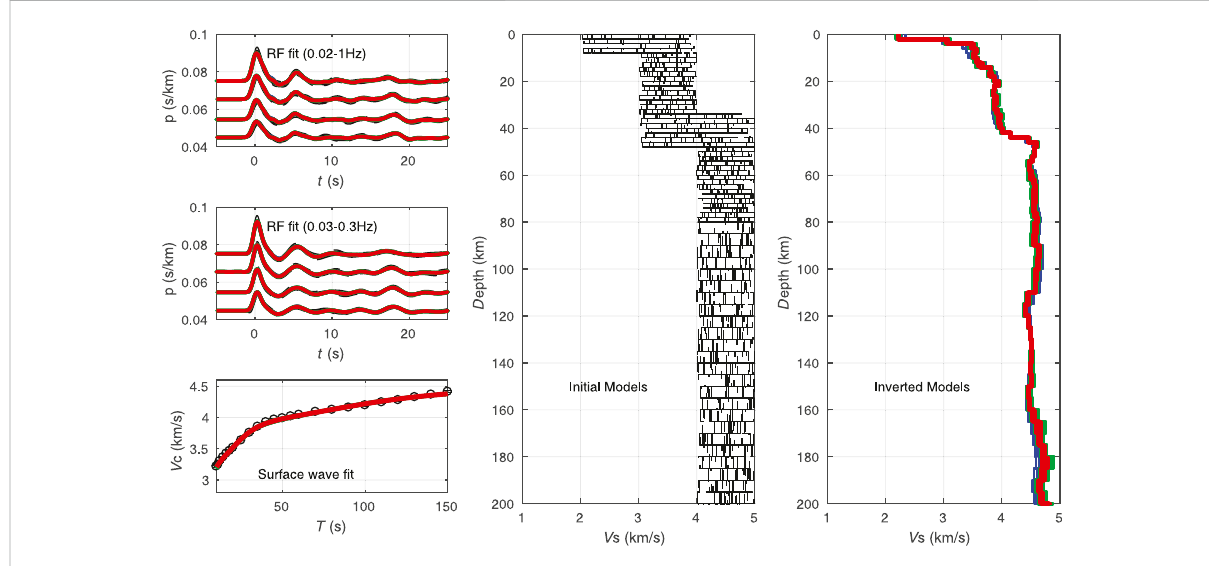
The joint inversion results at station SN. YULG located in Ordos block (shown in Figure 1). The 20 random models (black dashed lines) used as initialS-wavevelocitymodelsduringjointinversion.TheS-wavevelocitymodelderivedfrominversion,wherethegreenlinesaremodelswithasmall fi tted residual (less than 1.2 times the minimum residual), the blue lines are models with a large fi tted residual, and the solid red line represents the averagevalueanditsstandarddeviationofthegreenlines).Thestackedreceiverfunctions(blacklines)andthe fi ttedcurves(red,greenandblue lines) for 0.03 – 0.3 and 0.02 – 1 Hz, where t refers to time and p refers to horizontal slowness. The Rayleigh wave phase dispersion curve beneath the station (black circles) and the fi tted curve (red, green and blue lines), where T refers to period and Vc implies Rayleigh wave phase